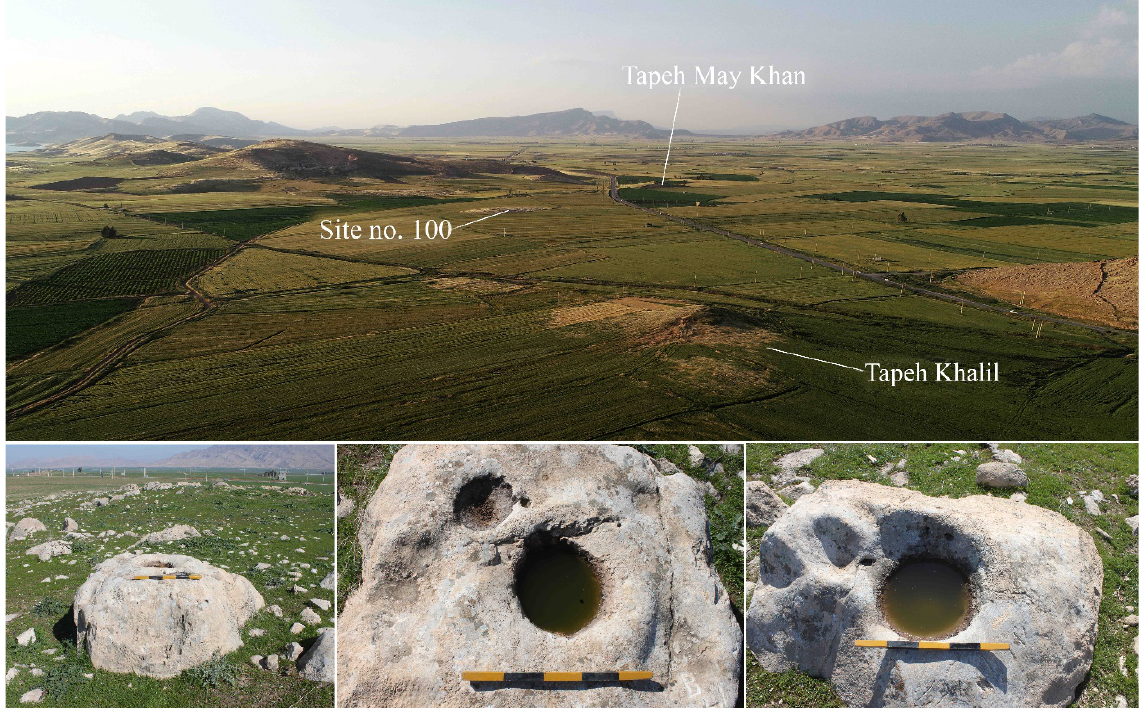
Figure 8. Aerial view of Chia Kuchegina (Site No. 100) and one of its rock mortars (courtesy of Reza